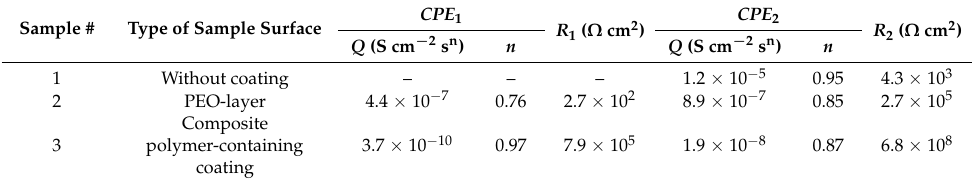
Figure 13. Open circuit potential changing versus time (2 h) for the 1579 aluminium alloy (with welded joint area) samples without coating (the lower curve), with PEO-coating (the middle curve), and with composite polymer-containing coating (the higher curve) obtained in 0.5 M NaCl solution. The last OCP value was held potentiostatically for EIS measurements. Table 3. Calculated parameters of the element of the equivalent electrical circuit for the samples made of the 1579 aluminium alloy (including the welded joint area) with different treatment. These parameters were used for a plot of fitting curves (solid lines in Figure 14).